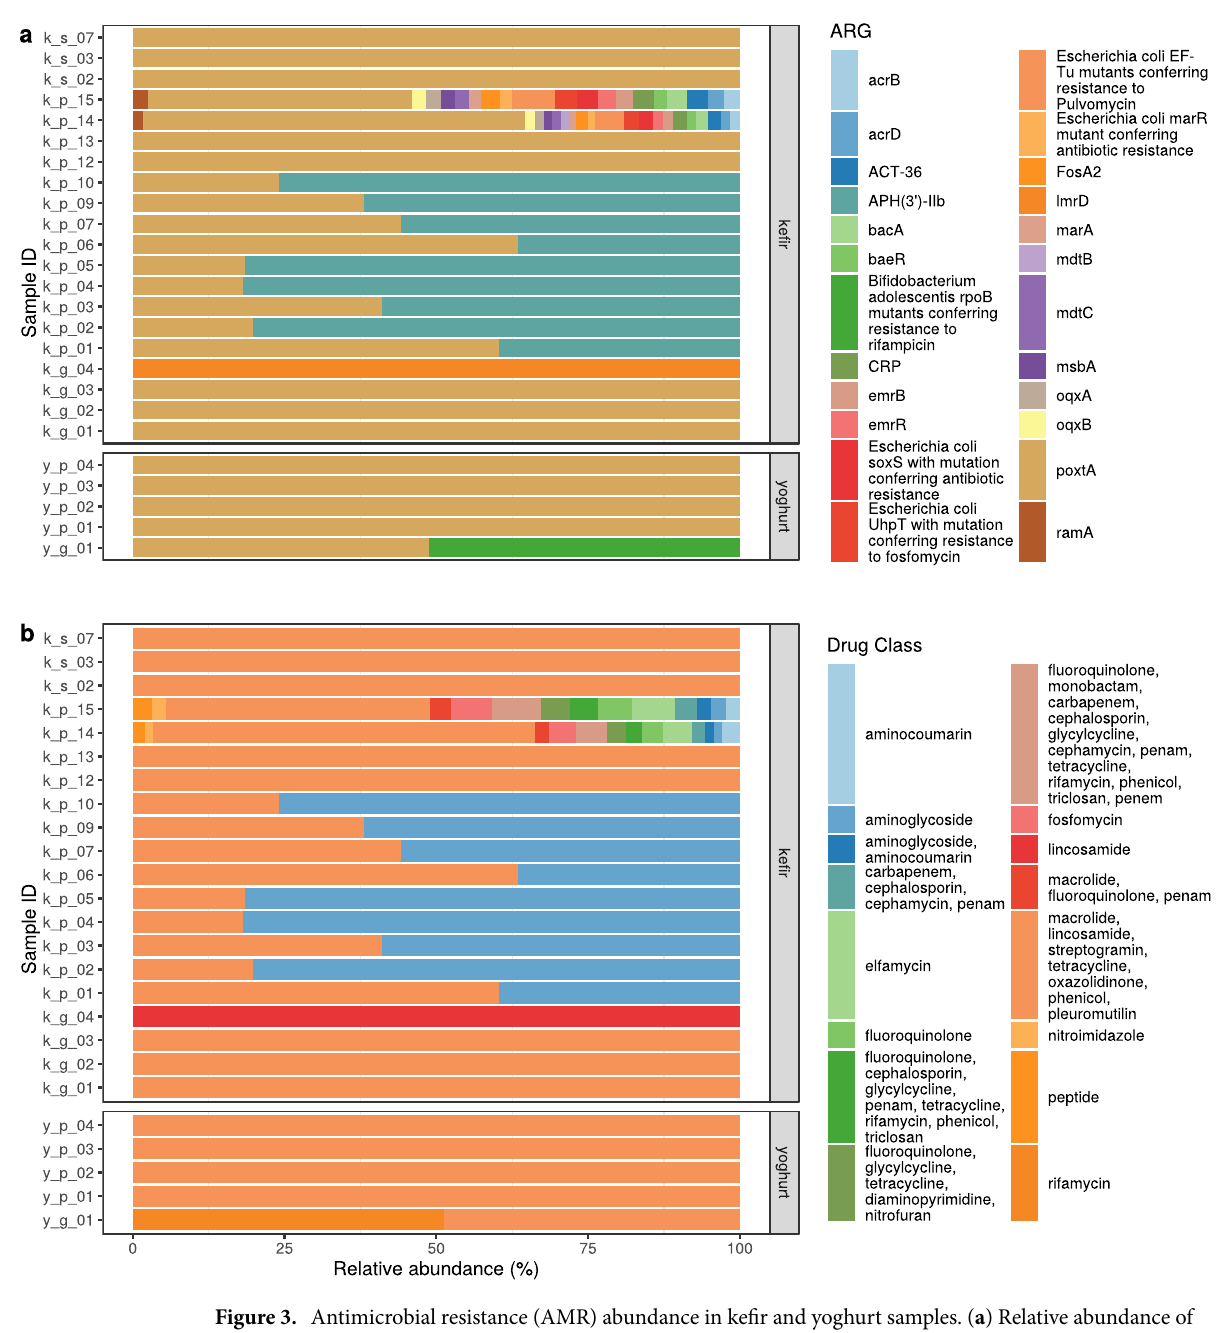
biotic efflux; reduced permeability to antibiotic (0.32%), antibiotic target alteration; antibiotic efflux; reduced